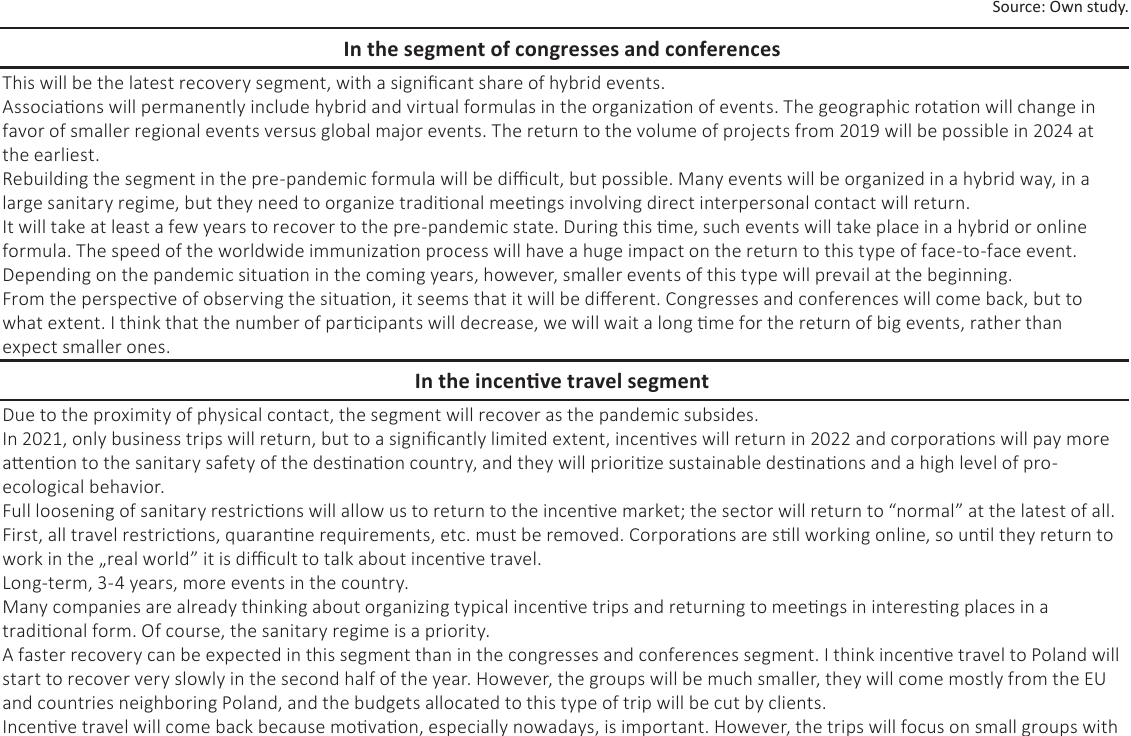
Table 6. Opinions of CEOs on the assessment of the prospects for recovery by segment